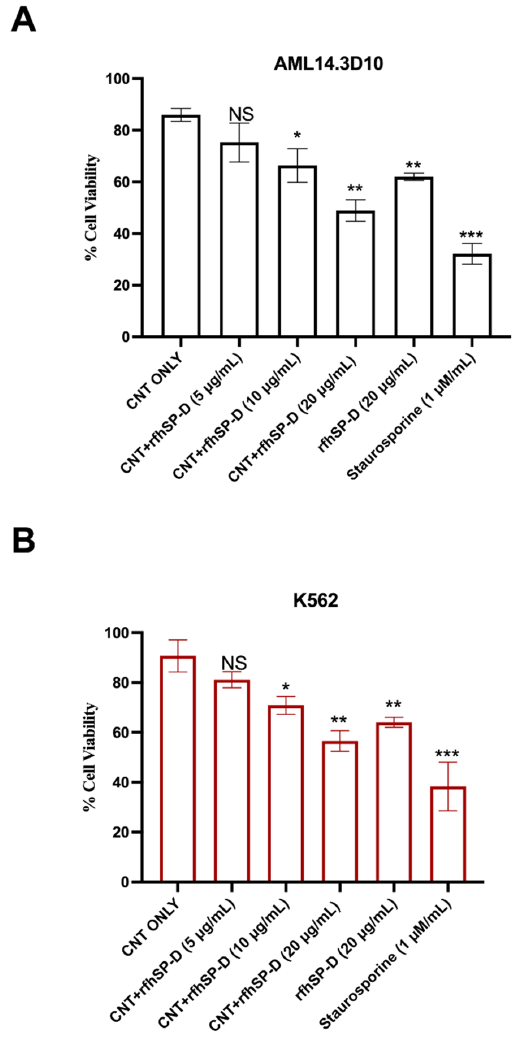
Figure 2. Cell viability following treatment with CNT+rfhSP ‐ D ‐ CNT in AML14.3D10 ( A ) and K562 ( B ) cell lines via trypan ‐ blue ‐ dye exclusion assay. Cells (0.1 × 10 5 ) were treated with CNT+rfhSP ‐ D (5, 10, 20 μ g/mL), rfhSP ‐ D (20 μ g/mL) or CNT alone (20 μ g/mL) for 24 h at 37 °C. The data has been normalized with cells only as 100% of the cell viability. * p < 0.05, ** p < 0.01 and *** p < 0.001 compared to CNT only group.